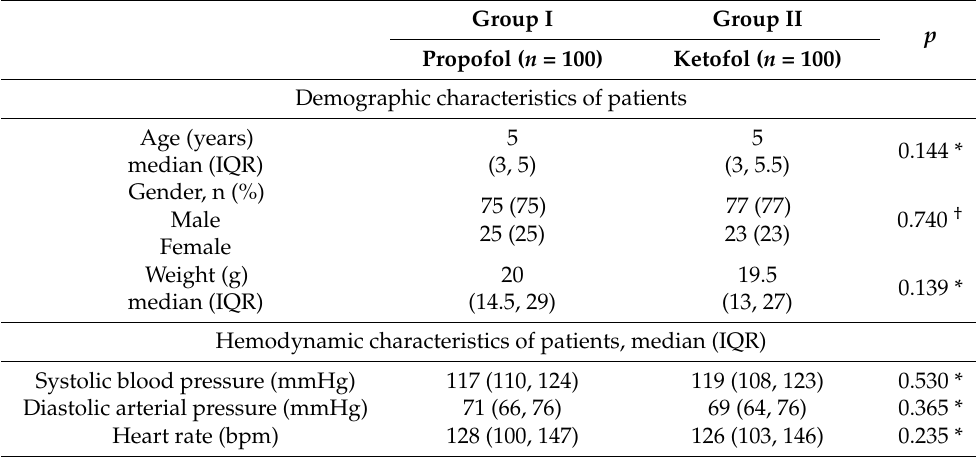
Table 1. Demographic and hemodynamic characteristics of patients.